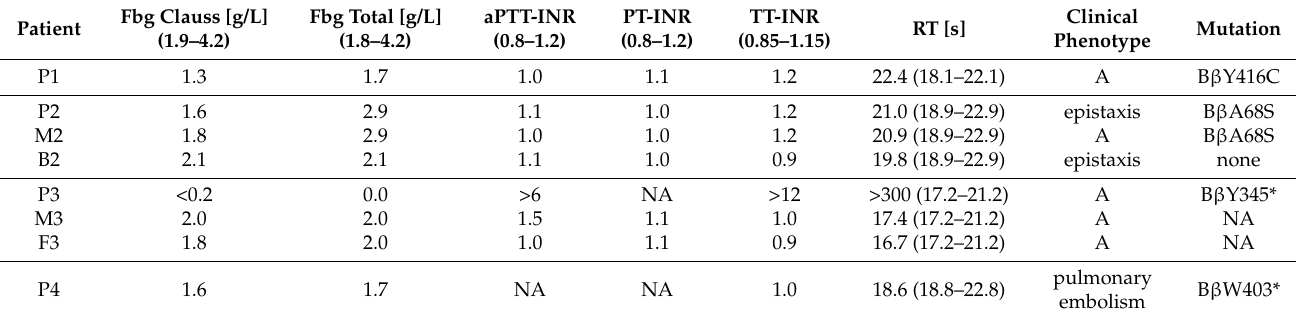
Table 1. Coagulation screening tests